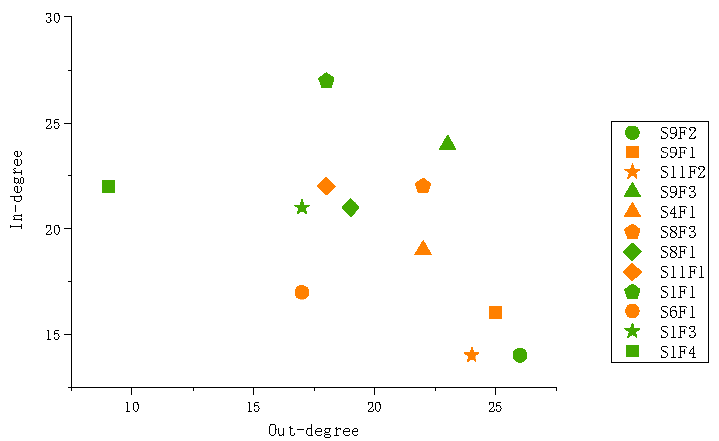
Figure 3. Dominance of the influencing factor based on in-degree centrality and out-degree centrality. Table 3. Receivers in the influencing factor